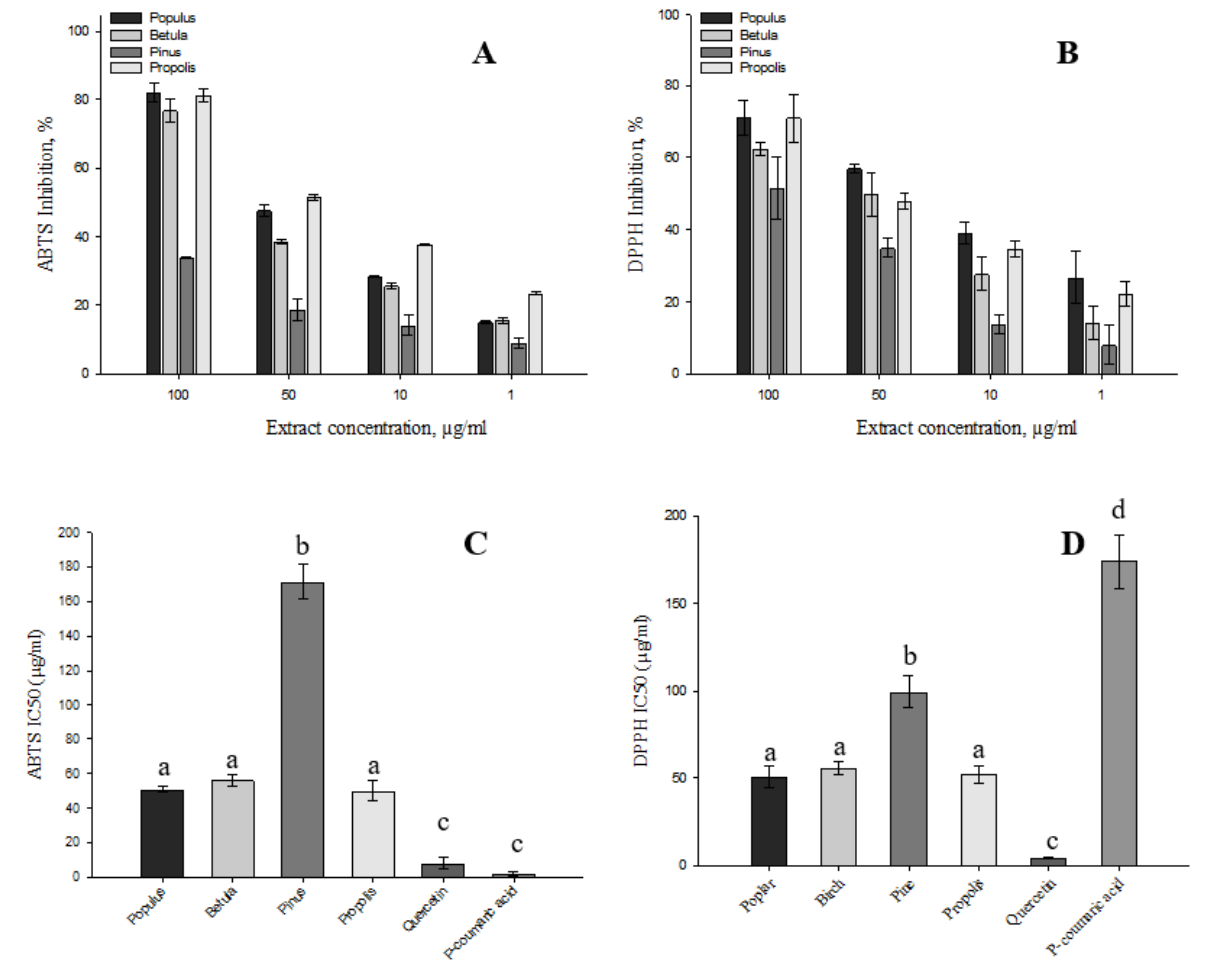
Figure 3. Antioxidant activity of poplar, birch, pine buds and propolis extracts. Subgraph ( A )—ABTS inhibition % of extracts (1 µ g CAE/mL to 100 µ g CAE/mL); subgraph ( B )—DPPH inhibition % of extracts (1 µ g CAE/mL to 100 µ g CAE/mL); subgraph ( C )—IC50 ABTS concentration; subgraph ( D )—IC50 DPPH concentration. Subscripts of different letters indicate statistically significant differ- ences between subjects ( p <